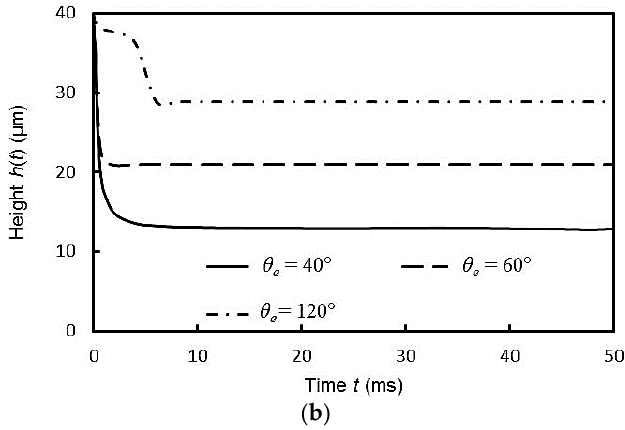
Figure 9. Variation in ( a ) spreading radius and ( b ) height versus the time.